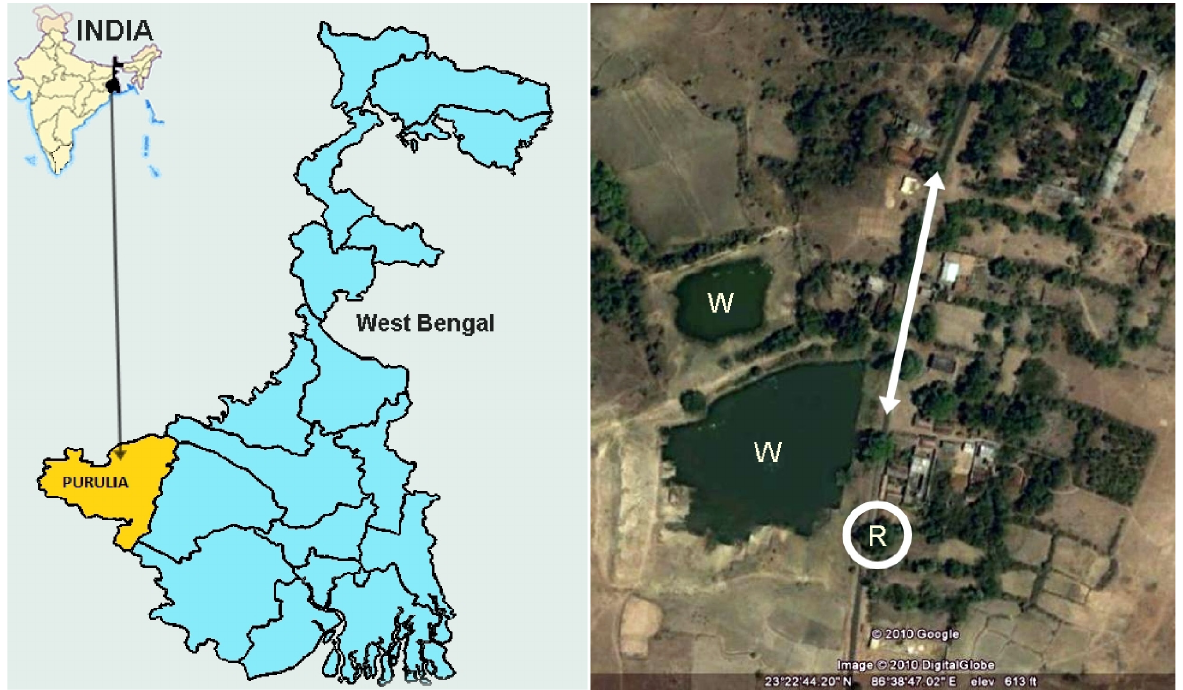
Figure 1. Map showing the study site under present investigation from SimlaVillage of Purulia District, West Bengal, India. Circle with ‘R’ indicates the bat colony roosting site; Arrow indicate Adra-Hura Road; W = water